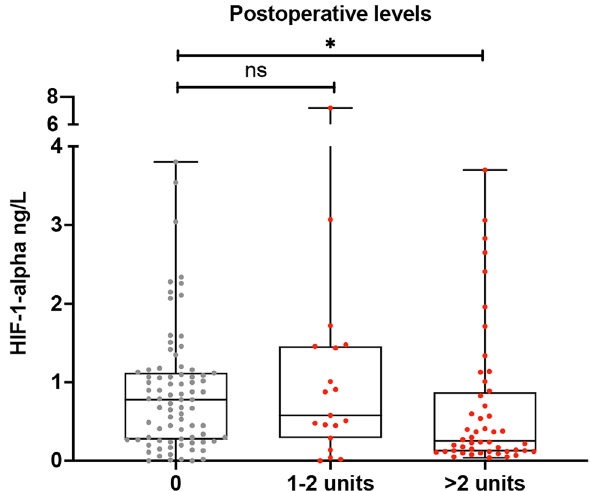
Figure 4. Postoperative hypoxia-inducible factor 1 alpha (HIF-1-α) levels according to the number of transfused red blood cell units. The vertical axis represents HIF-1α cytokine levels (ng/L). The horizontal axis represents red blood cell units in three groups.